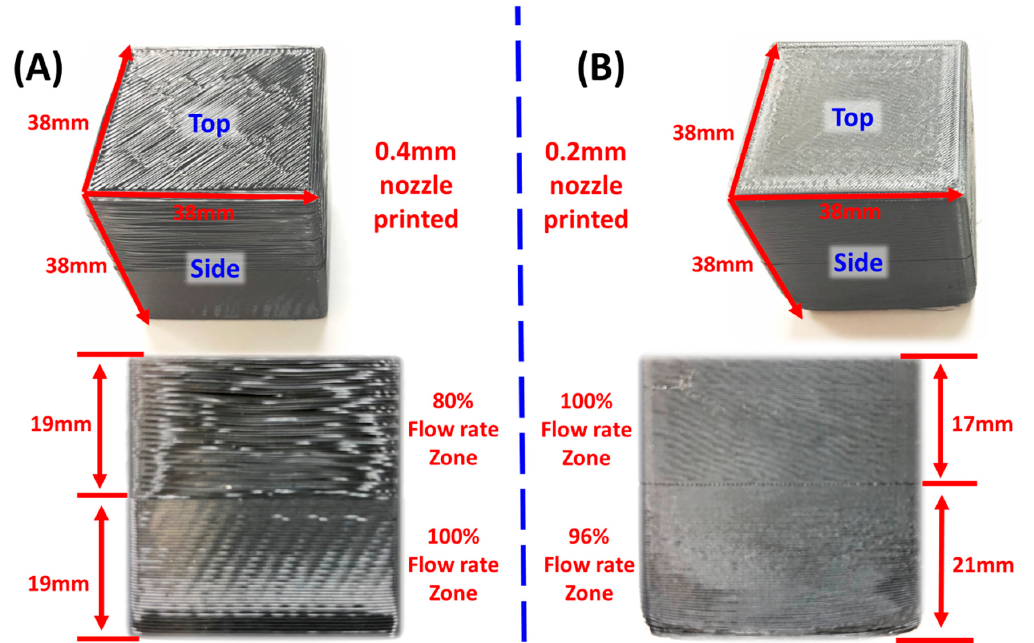
Figure 1. FDM printed ABS blocks for elastography testing of size 38 mm × 38 mm × 38 mm. ( A ) Sample 1 was printed using a 0.4 mm nozzle under a 100% flow rate and an 80% flow rate setting. The height of both regions was 19 mm. ( B ) Sample 2 was printed using a 0.2 mm nozzle under a 96% flow rate region with a height of 21 mm and a 100% flow rate zone had the height 17 mm.